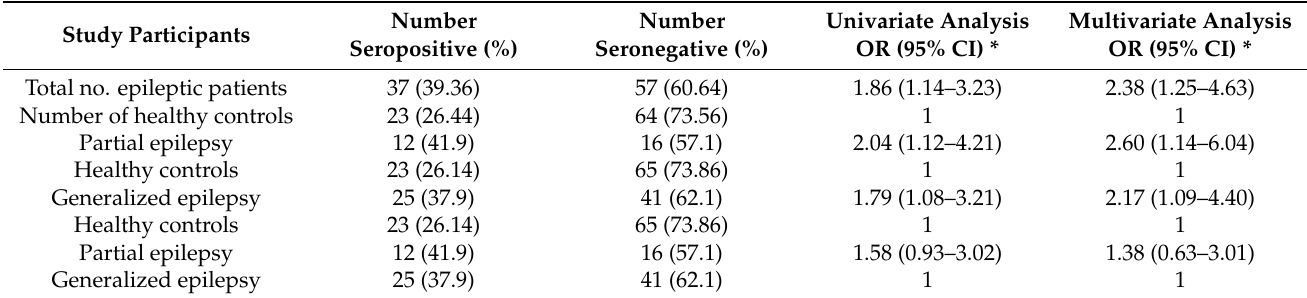
Table 2. Univariate and multivariate analyses to assess whether there is an association between epilepsy and seropositivity to Toxocara in